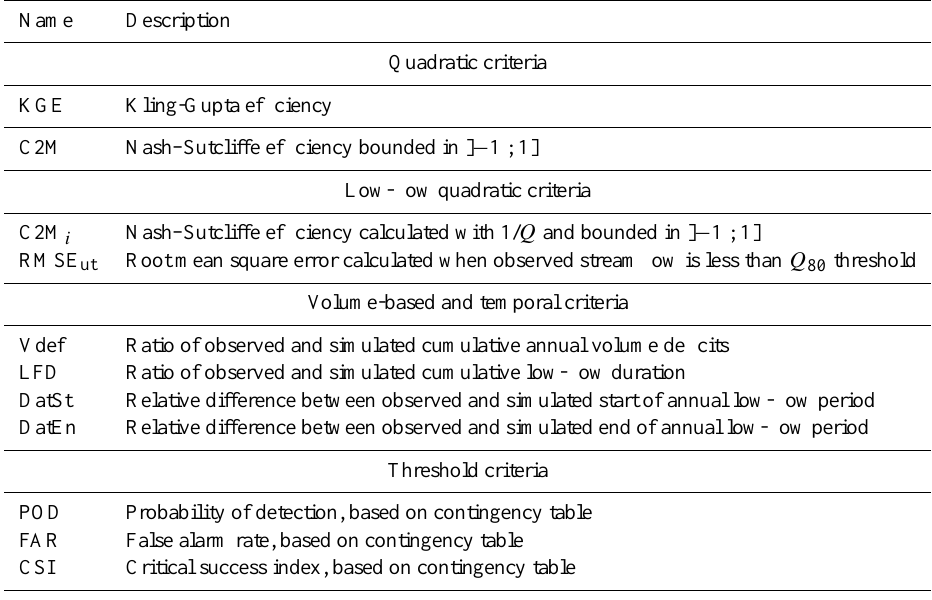
Table 4. List of efficiency criteria used for model evaluation in simulation mode (see details in Appendix).